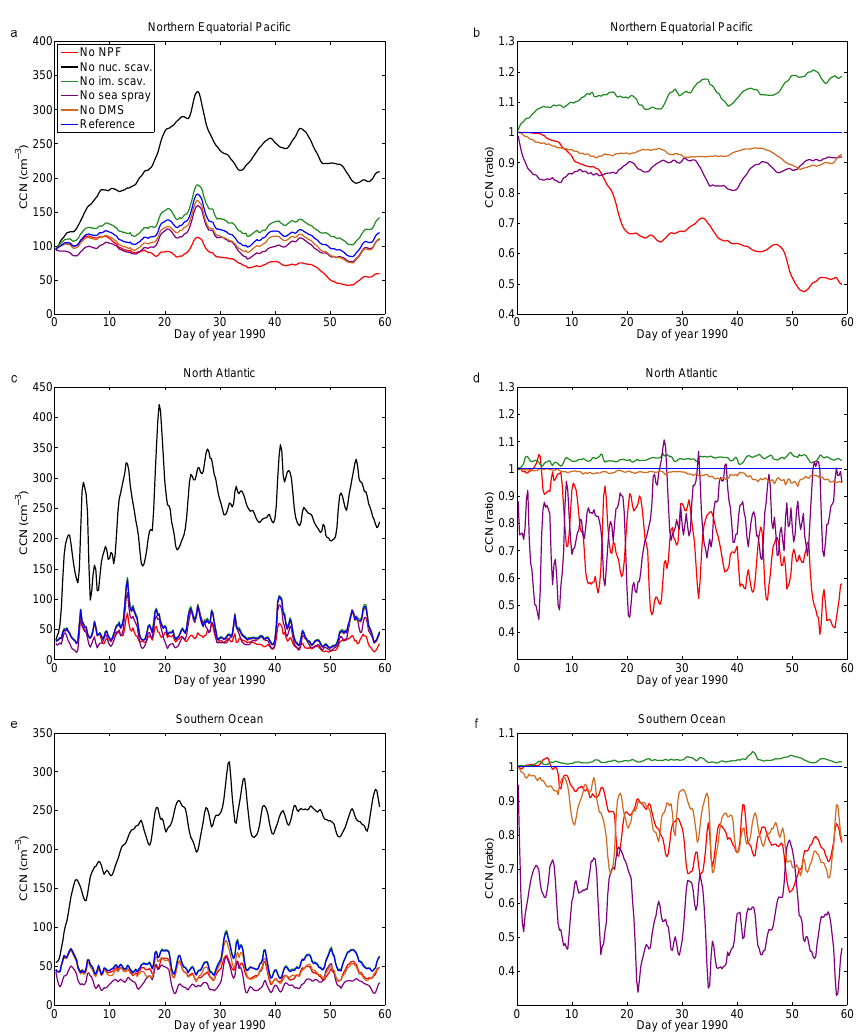
Figure 4. CCN concentrations (left plots) and ratio to reference concentrations (right plots) at 930hPa in the Northern Equatorial Pacific (a, b) , the Southern Ocean (c, d) , and the North Atlantic (e, f) in January 1990.